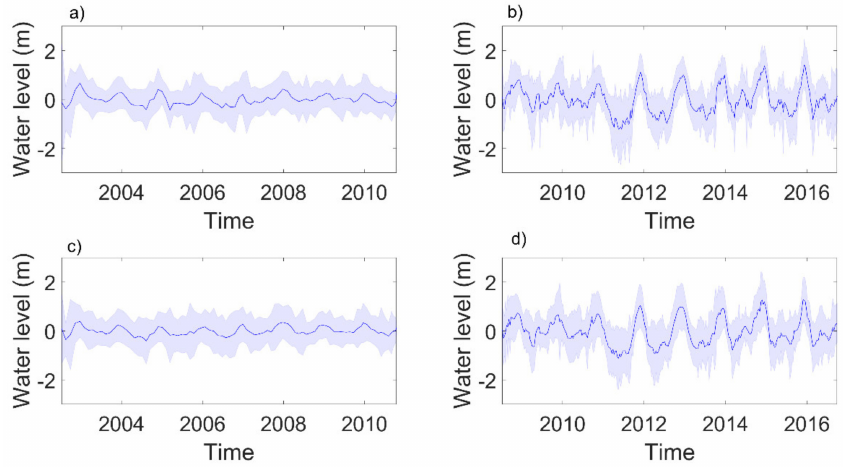
Figure 11. Time series of anomaly of water levels averaged over all the stations located on the river and the permanently inundated areas from ( a ) ENVISAT and ( b ) Jason-2, and over the non- permanently inundated areas from ( c ) ENVISAT and ( d )